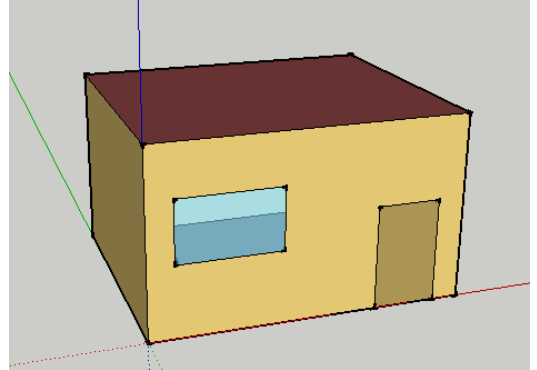
Figure 2. Architectural model.